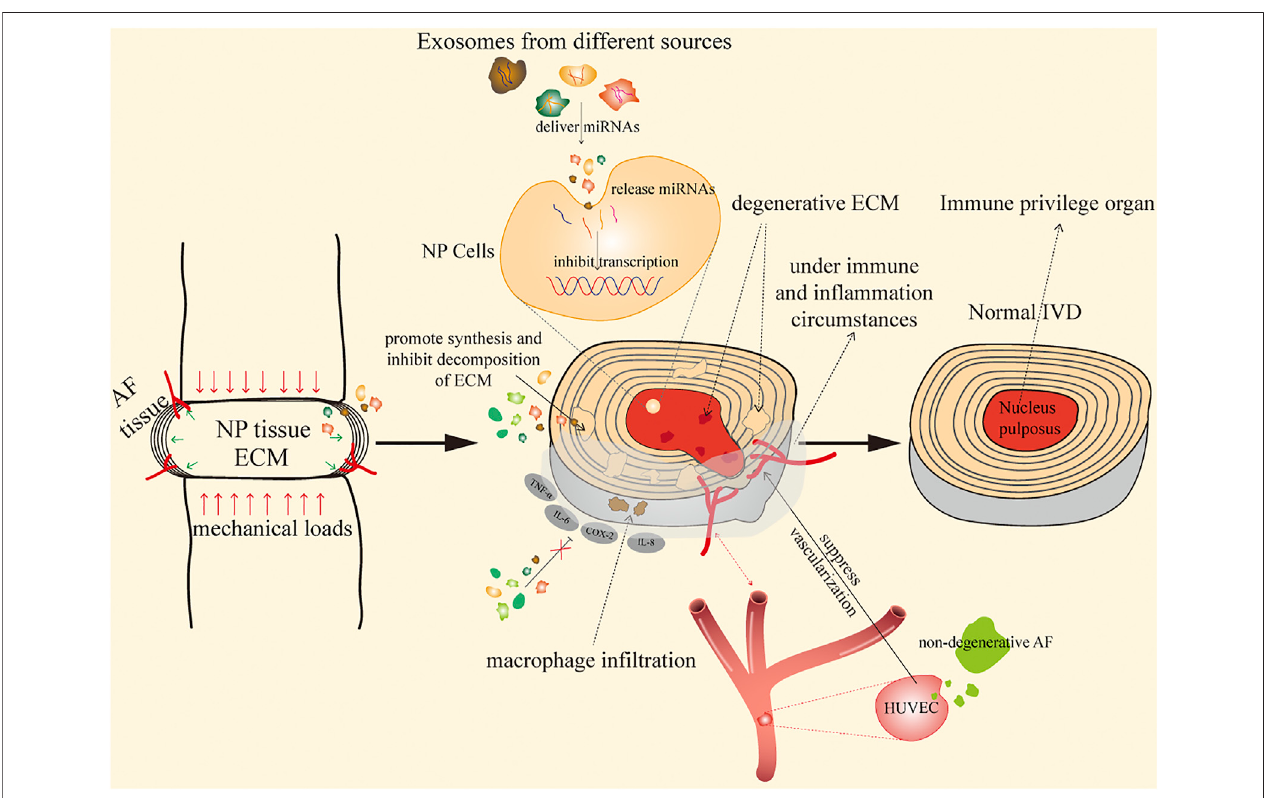
FIGURE 1 | Mechanisms of exosomes in the treatment of